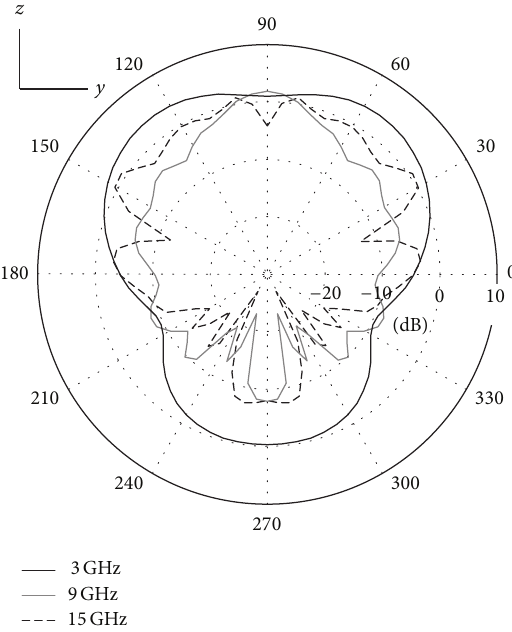
Figure 19: Radiation pattern of a semiplanar conical antenna with elliptical aperture and reflector in the yz plane.